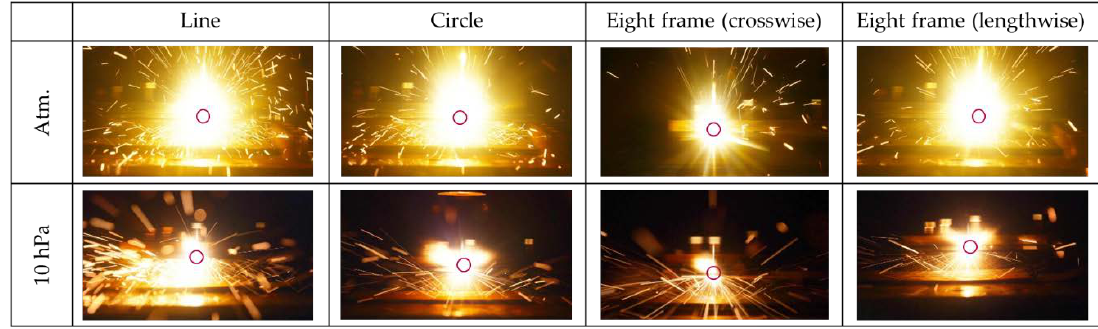
Figure 8. Spatter formation and metal vapour plume using di ff erent laser oscillation patterns at atmospheric pressure and 10 hPa; weld location marked with red